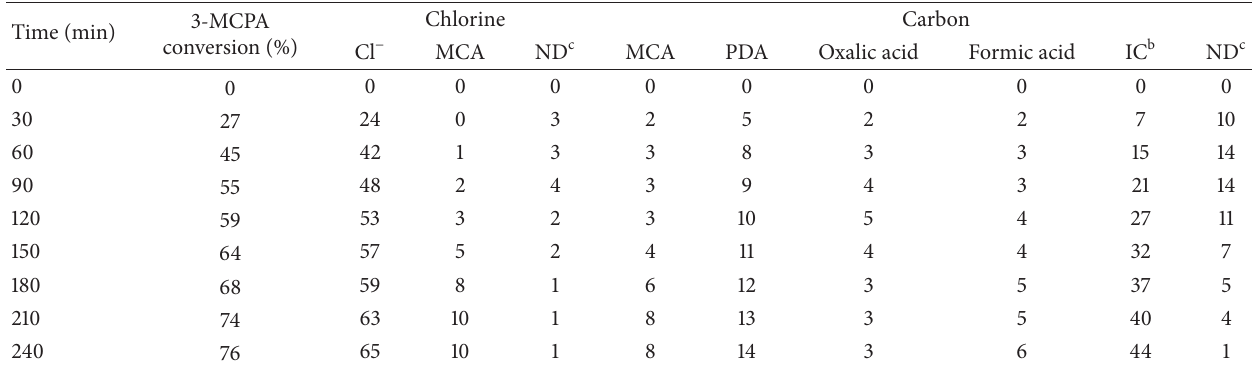
Table 1: Elemental yields of products from CGDE of 3-MCPA a .